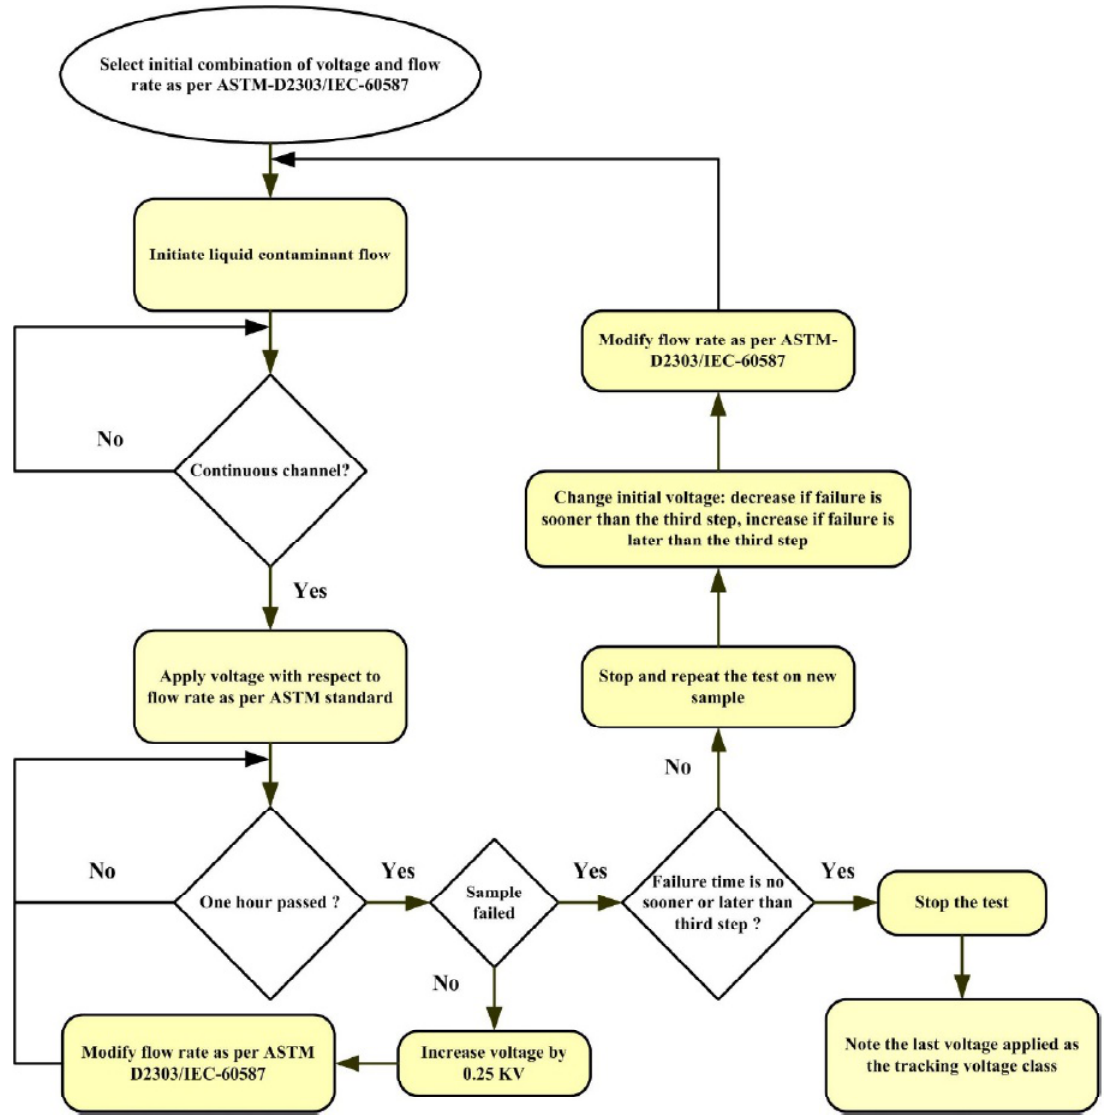
Fig. 11. I nclined-plane-test stepwise